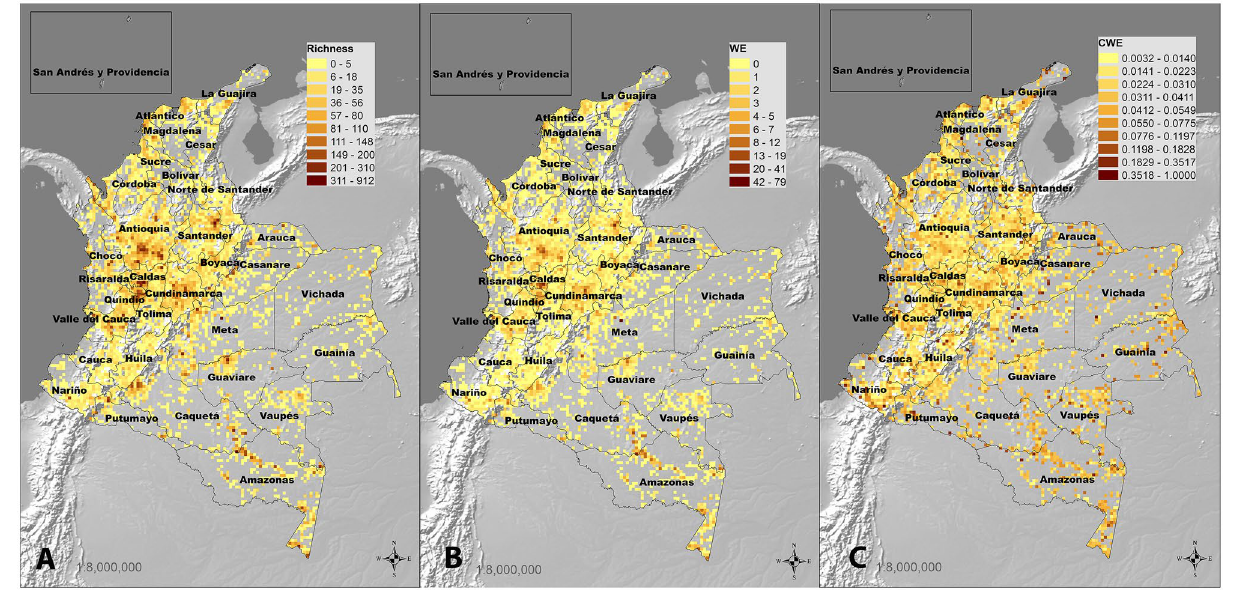
Figure 4. Diversity patterns of Colombian edible plants. ( A ) Species richness (SR) map; ( B ) Weighted Endemism (WE) map. ( C ) Corrected Weighted Endemism (CWE). Generated in ArcGIS Pro 2.9.0. https:// www. arcgis. com/ index.